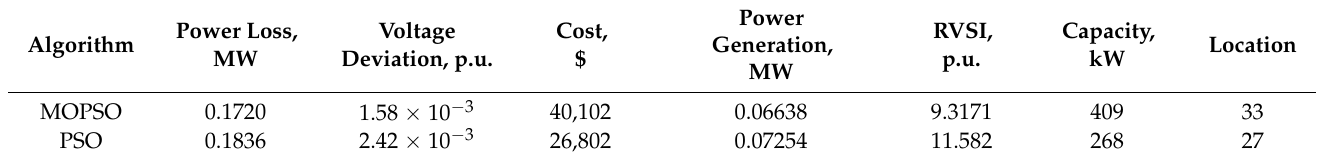
Table 7. Comparison of the results of MOPSO algorithm and PSO algorithm (one BESS connection).